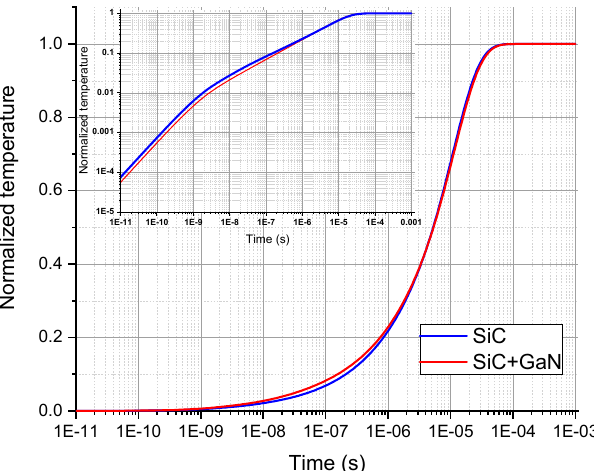
Figure 7. Comparison of transient normalized temperature simulation for one-layer and two-layer structures.